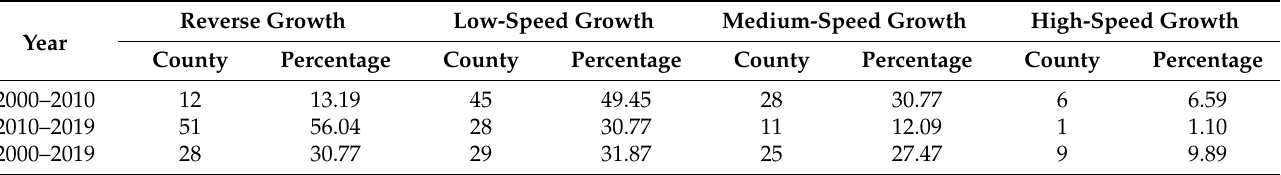
Table 4. Graded statistics of the rate of change in accessibility of educational facilities,